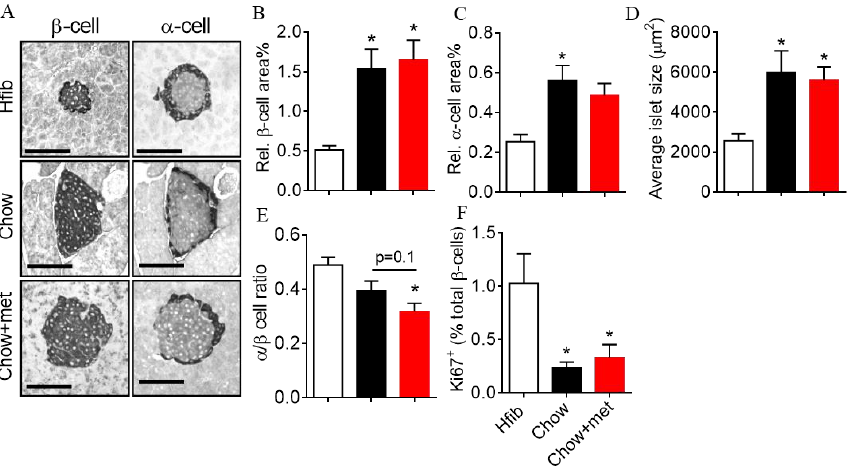
Figure 5. Pancreatic α -/ β -cell area and β -cell proliferation. ( A , F ): representative images of insulin and glucagon staining; ( B , C ): relative β - ( B ) and α -cell ( C ) area to the total pancreas area; ( D ): average islet size; ( E ): Ratio of α - to β -cell area; ( F ): Percentage of the number of proliferating β -cell to the total number of β -cell. n = 5 in Hfib group; n = 11 in Chow and Chow-met groups. * p < 0.05 using the Kruskal–Wallis test followed by Dunn’s multiple comparisons tests. Scale bar = 100 μm.